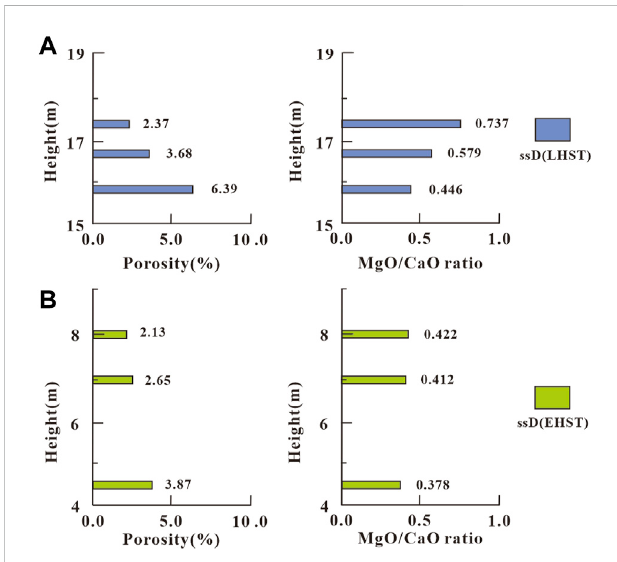
FIGURE 13 Mechanism of porosity increase in the upper changping formation, dingjiatan section. The samples in panel (A) are from the dingjiatan section, and those in panel (B) are from the miaofengshan